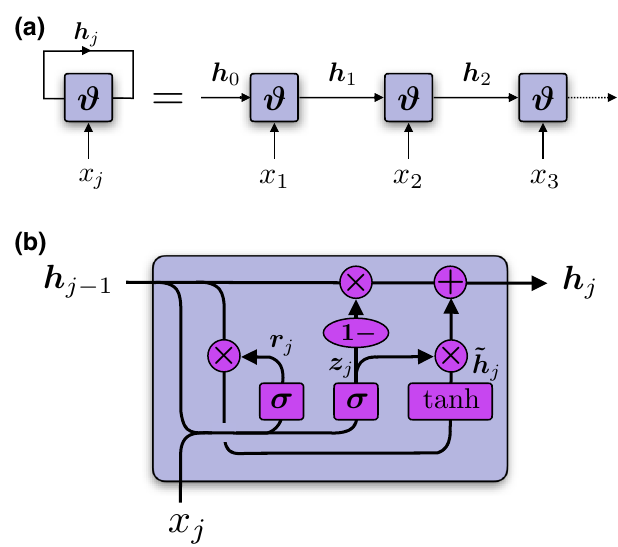
FIG. 6. Recurrent neural network. (a). A generic RNN cell (left) and its unrolling in time to process sequenced data (right). (b) The gated recurrent unit, and the set of operations used to pro- cess the input latent state h j − 1 and visible state x j to generate a new latent state h j . Lines joining together means concatenation, while the circles are element-wise